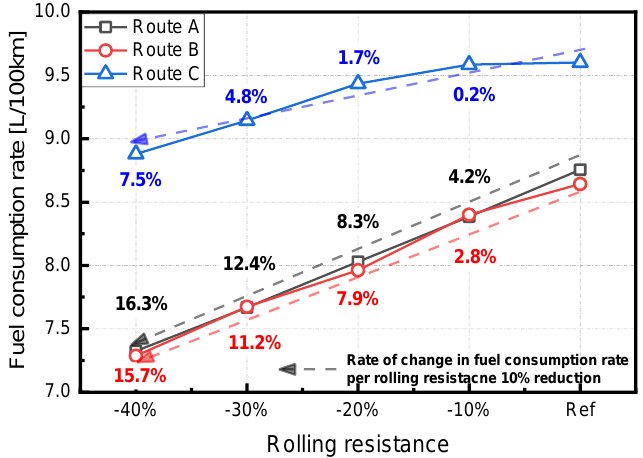
Figure 10. Fuel consumption rate with respect to rolling resistance.